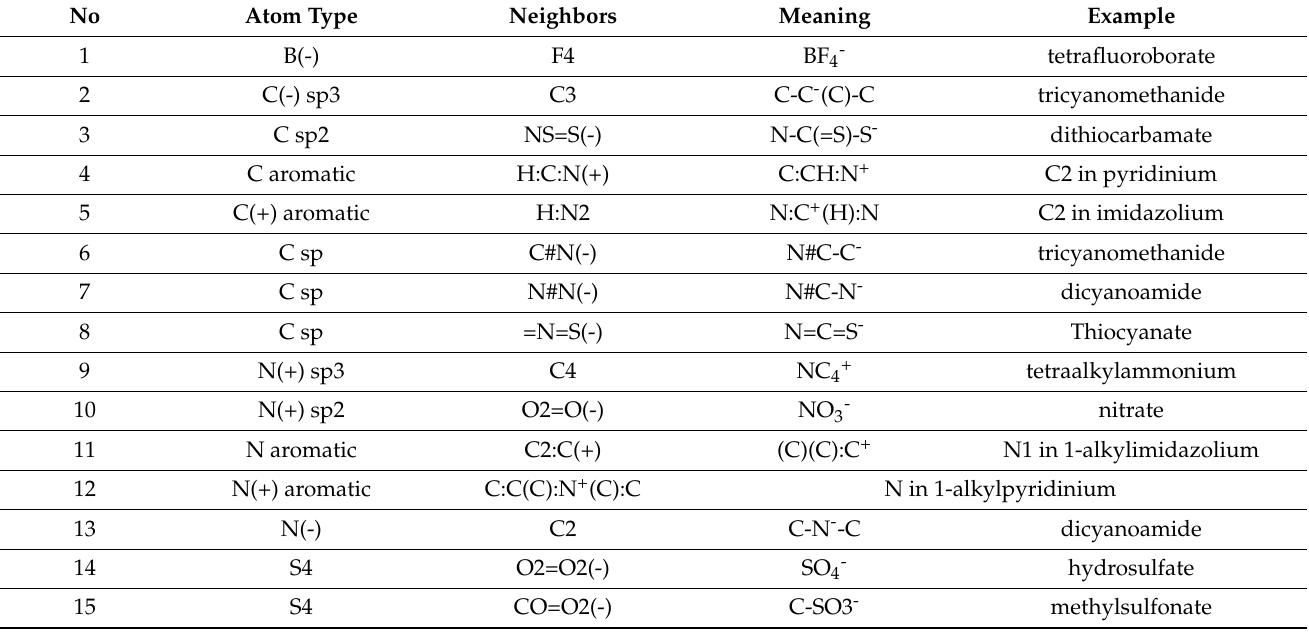
Table 1. Charged Atom Groups and their